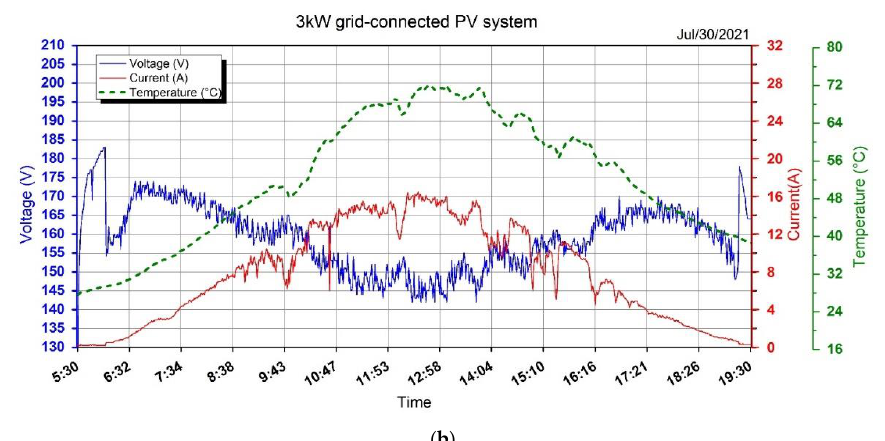
Figure 16. Various data obtained from PV junction box for a day in summer: ( a ) Power and energy flow; ( b ) Voltage, current and temperature flow.